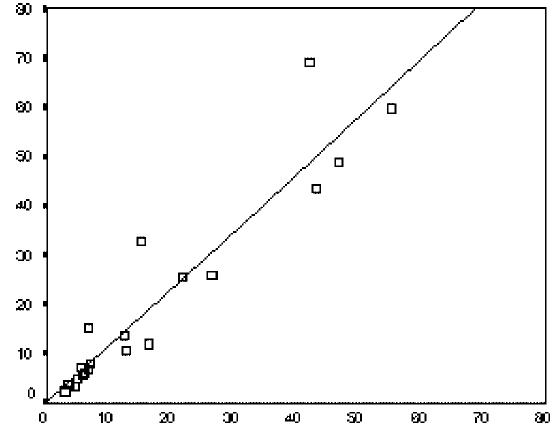
Fig. 3. Correlation between consecutive measurements – total area of connective tissue of the reticular dermis present within one sec- tion given in mm 2 as obtained in the test set of 10 cases each of nor- mal human skin and primary melanoma (linear regression analysis: r = 0 . 94, p < 0 .